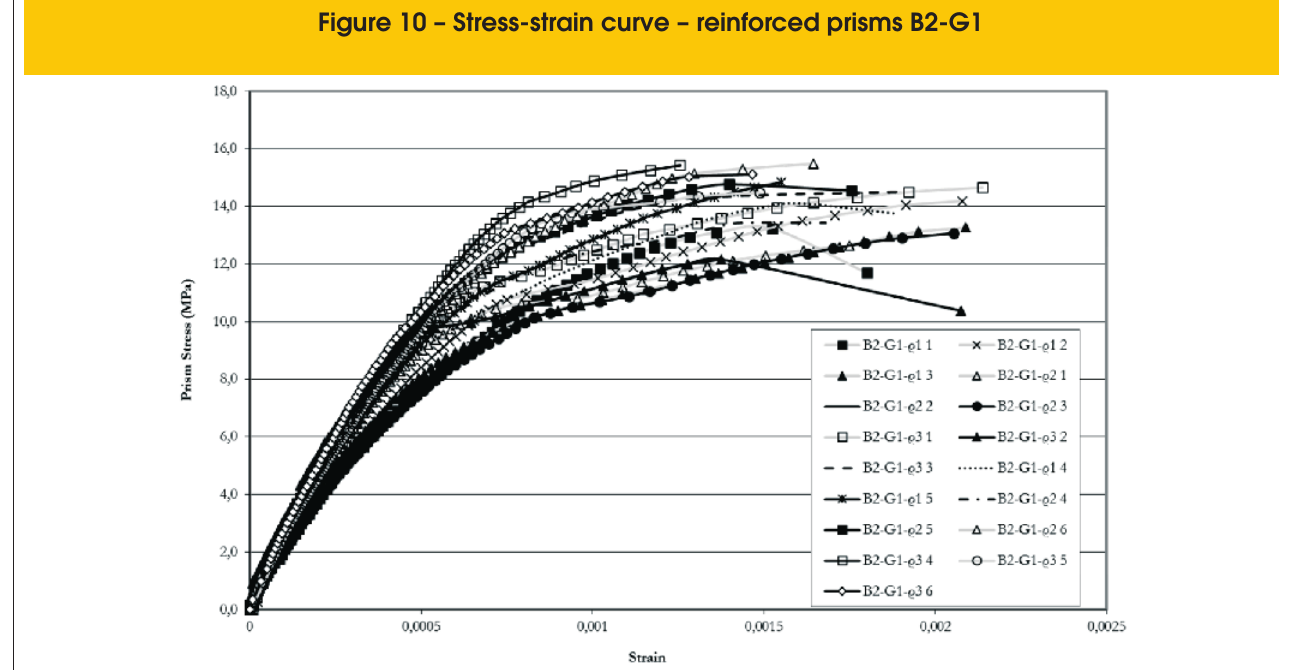
Figure 10 – Stress-strain curve – reinforced prisms B2-G1